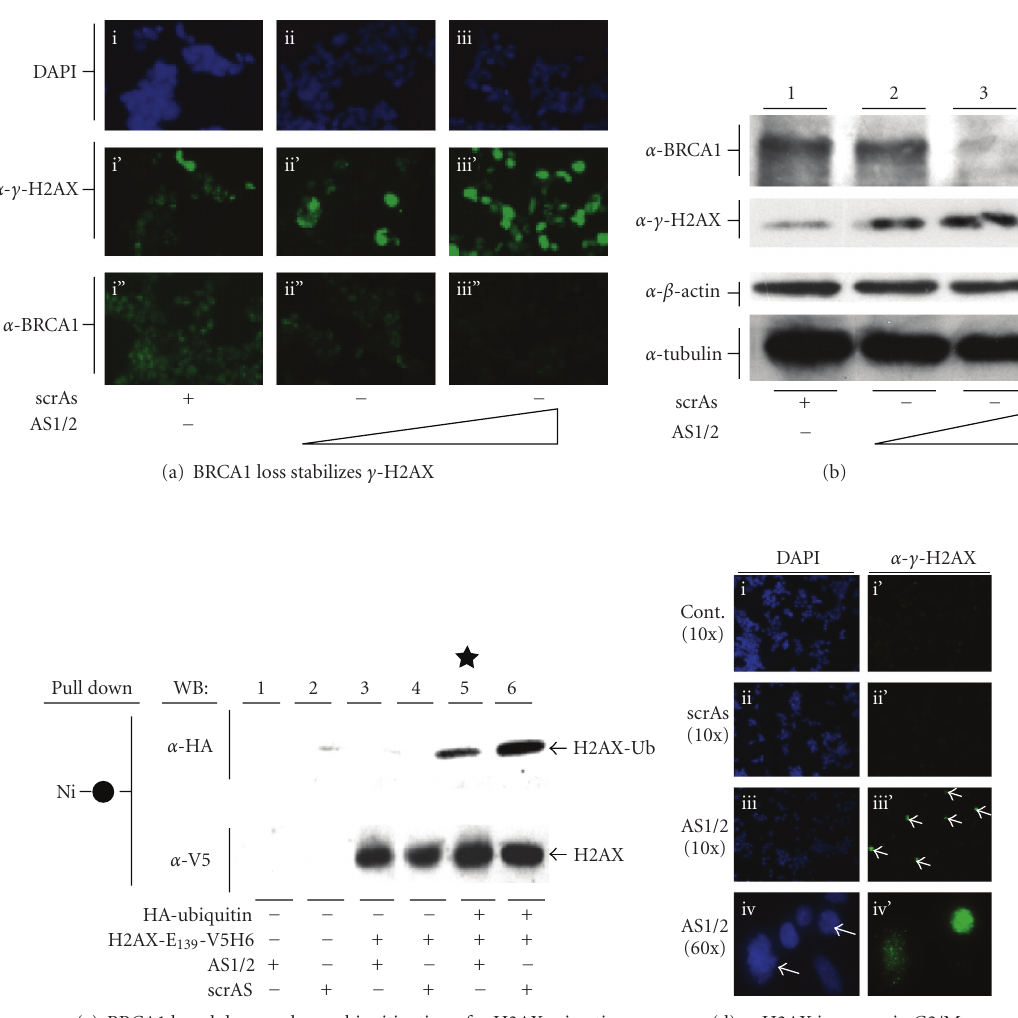
Figure 4: BRCA1 knockdown stabilizes γ -H2AX and reduces ubiquitination of γ -H2AX. (a) Cells treated with di ff erent amounts of antisense morpholino oligos (AS1 and AS2) or a scrambled antisense morpholino (scrAS) were stained with DAPI or immunostained for γ -H2AX. A second set of morpholino-treated cells was immunostained for BRCA1 to show dose-dependent knockdown of BRCA1 protein. (b) Cells treated with scrambled antisense morpholino (lane 1, scrAS) or increasing amounts of antisense morpholino oligos (AS1/2, lanes 2 and 3) were lysed and separated by SDS-PAGE and probed (WB) for BRCA1, γ -H2AX, β -actin, or β -tubulin. ( c ) 293T cells were treated with control (scrambled antisense (scrAS) or BRCA1 antisense morpholino oligos (AS1/2) and then transfected with control vector, HA-ubiquitin alone, and/or H2AX-E139-V5-H6. Histidine- (H6-) tagged H2AX was purified from chromatin fractions then probed for HA-ubiquitin. The blot was stripped and reprobed for V5-tag on H2AX. (d) Cells treated with a scrambled antisense morpholino (scrAS) or anti-BRCA1 morpholino oligos (AS1/2) were stained with DAPI (i–iv) or immunostained for γ -H2AX (i’–iv’). Micrographs were captured with either 10x (i–iii) or 60x (iv) objectives. Final magnification was 100x or